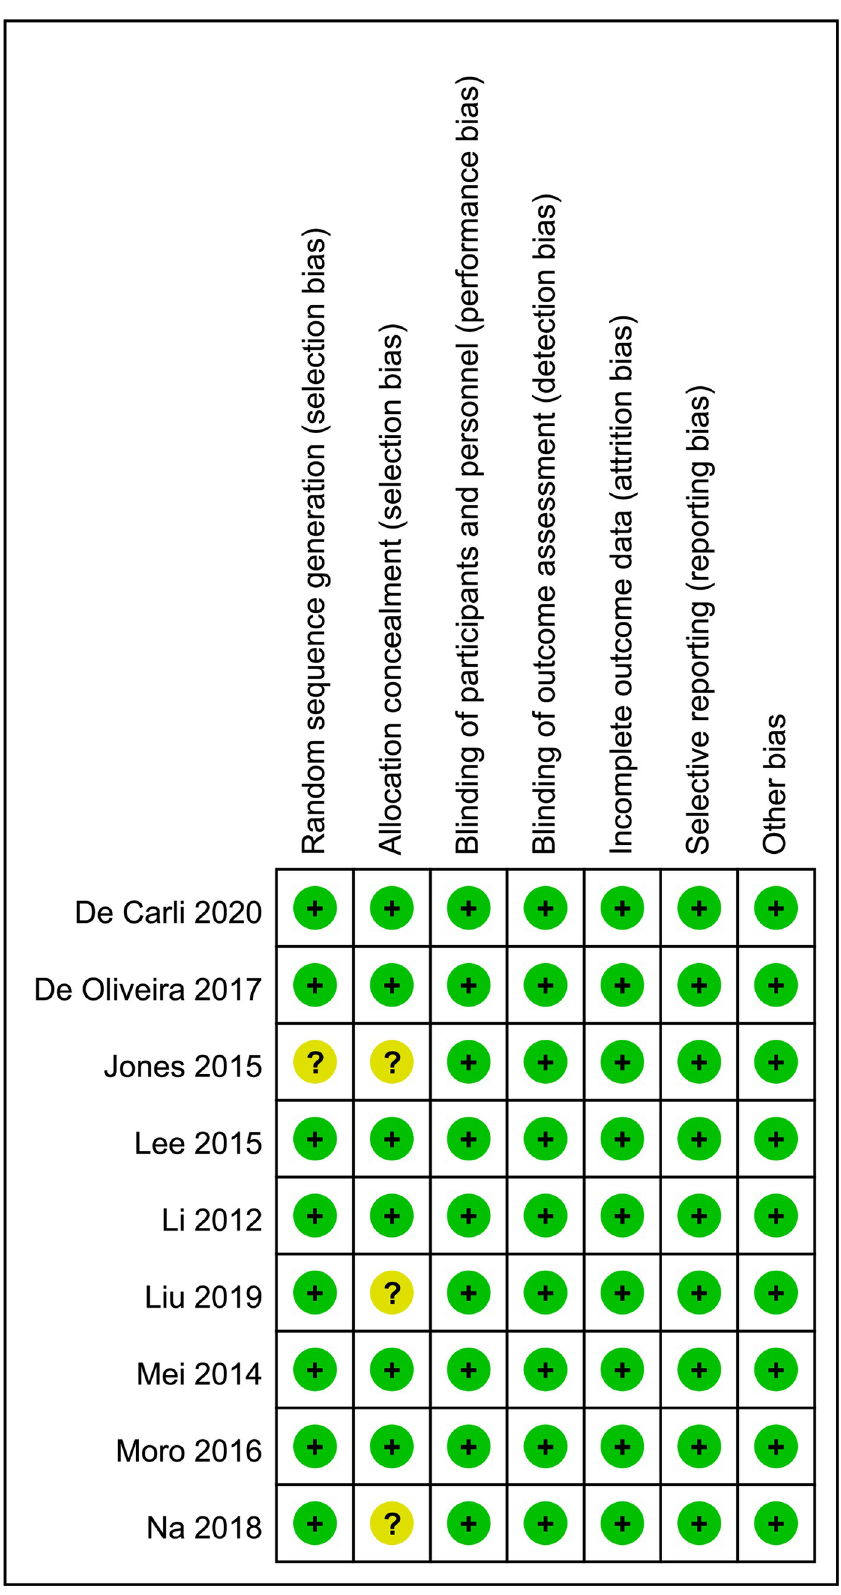
Fig 2. Risk of bias summary: Review authors’ judgements about each risk of bias item for each included study. https://doi.org/10.1371/journal.pone.0254271.g002 PLOS ONE | https://doi.org/10.1371/journal.pone.0254271 July 16,